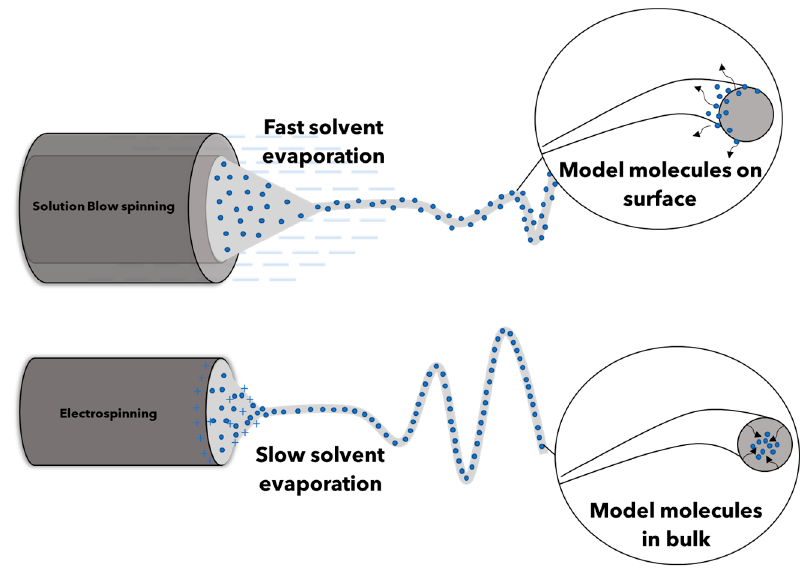
Figure 8. Pictorial representation of incorporation in SBS and ES processes.